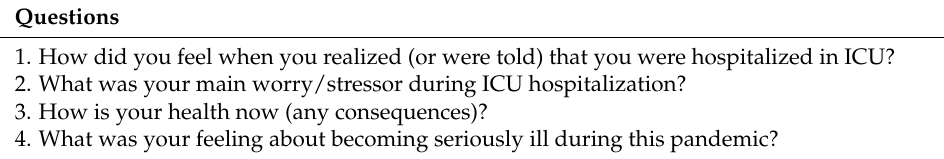
Table 1. Semi-structured interview